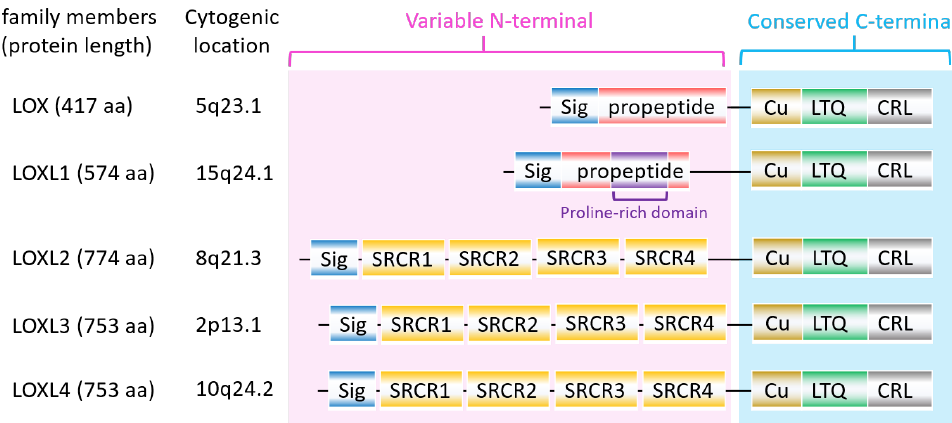
Figure 1. The structure of lysyl oxidase (LOX) family members. LOX family members encoded by the human LOX/LOXLs genes are located at various chromosome sites, including 5q23.1, 15q24.1, 8p21.3, 2p13.1, and 10q24.2. These members consist of a variable N-terminal domain and a highly conserved C-terminal domain. Sig, signal peptide (Sig); copper binding domain (Cu); lysyl-tyrosyl-quinone (LTQ) co-factor; scavenger receptor cysteine-rich (SRCR) domain; cytokine receptor-like (CRL)